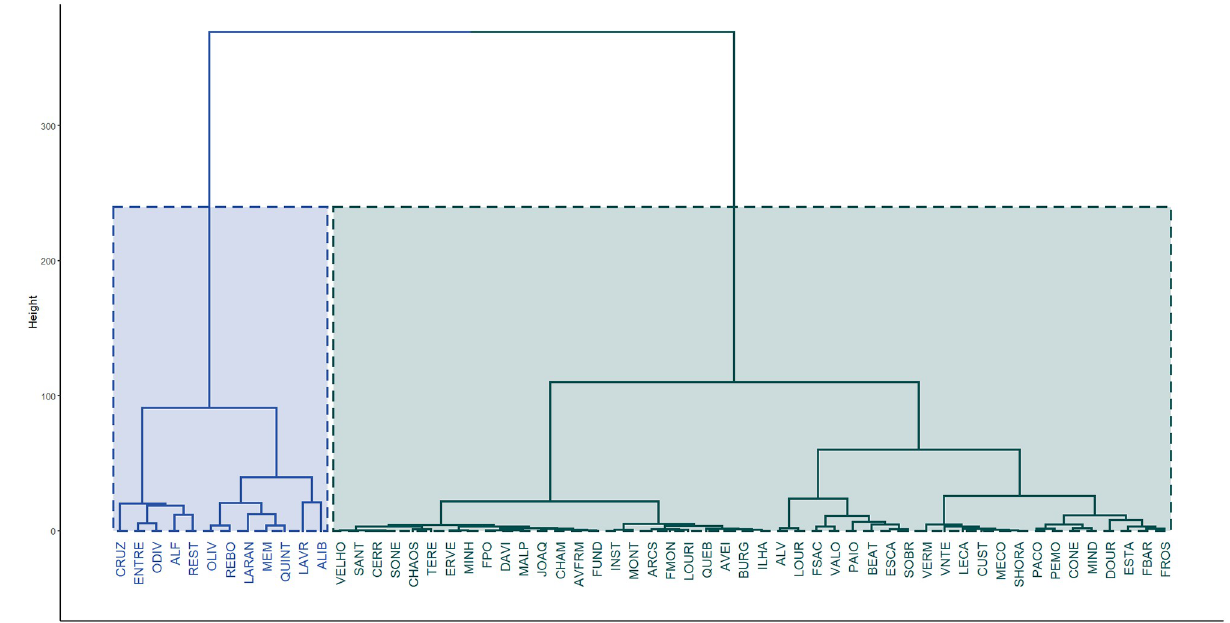
Fig 11. Dendrogram of the estimated one-step-ahead forecast pdfs highlighting the identified clusters. (a) Cluster 1 (blue) and (b) Cluster 2 (green).